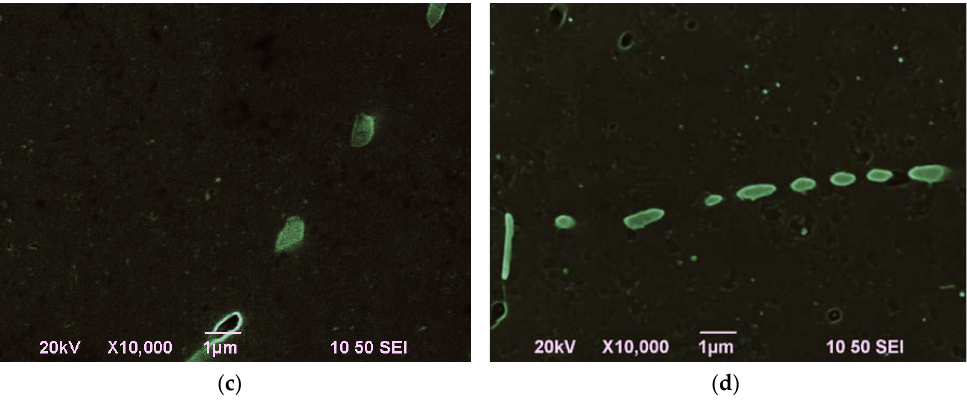
Figure 5. Images revealing the spheroidization and necklace formation after 6 h holding time. ( a ) Pinching leading to particle separation; ( b ) separated particles; ( c ) isolated particles after pinching; ( d ) neclace formation (aligned particles).